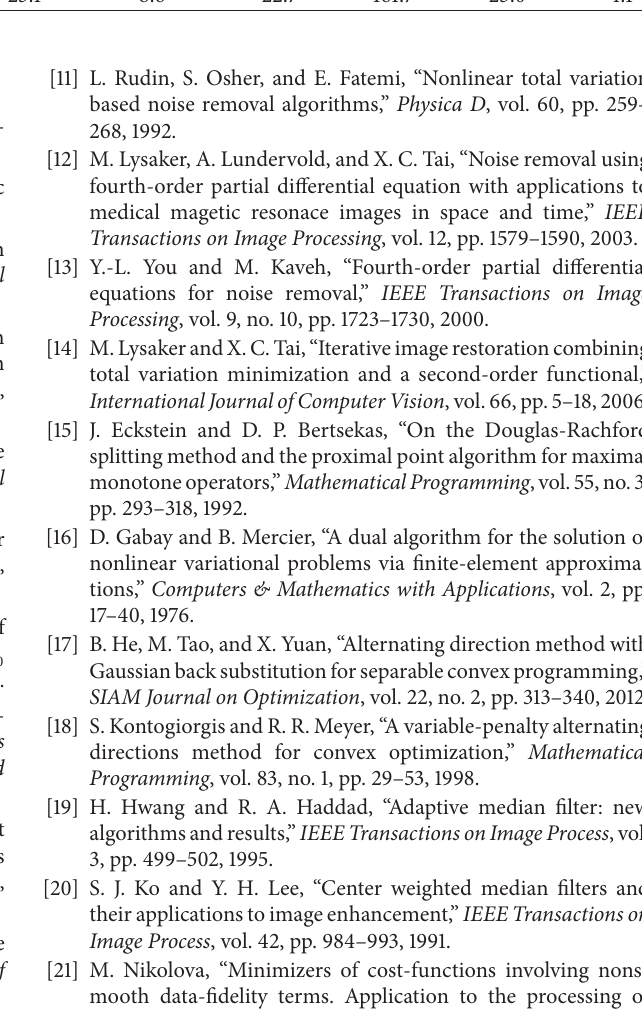
Gaussian + random